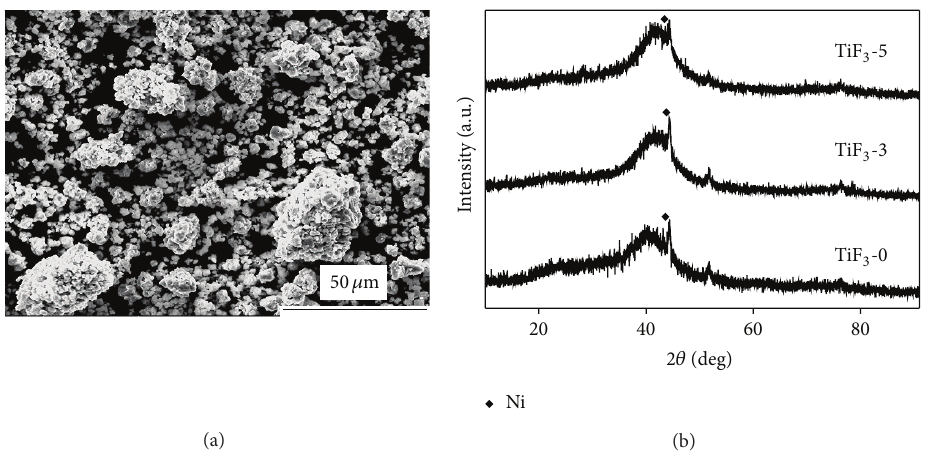
Figure 1: The granular morphologies and XRD patterns of the